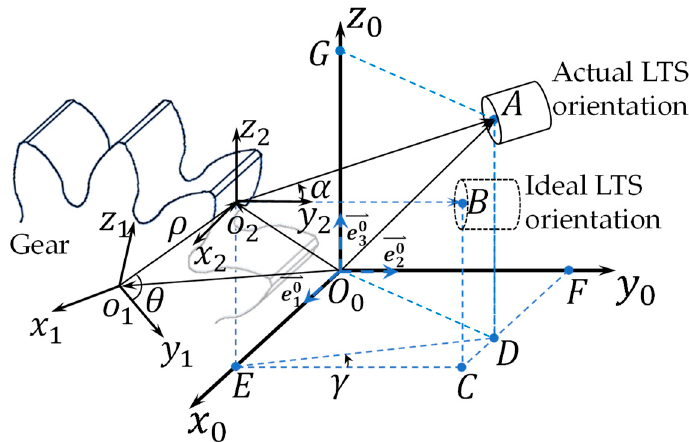
Figure 2. The spatial geometrical relations of the LTS with respect to the target gear, the pitch angle ( α ) and yaw angle ( γ ) are exaggerated for illustration. Note the proposed measurement system employs two LTS’s facing opposite directions, only one LTS is shown here for clarity. The other geometrical relationship is the mirrored image about the x 1 axis.